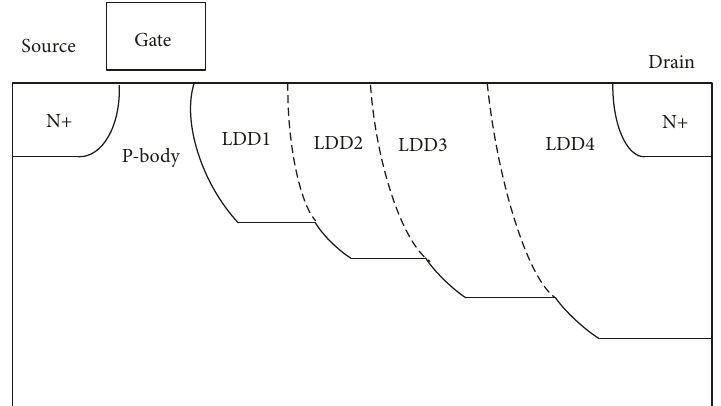
Figure 3: Structure of LDMOS drift region.